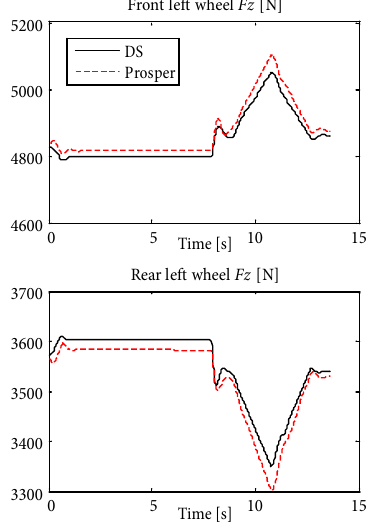
Fig. 9. Tire’s lateral force – overtaking